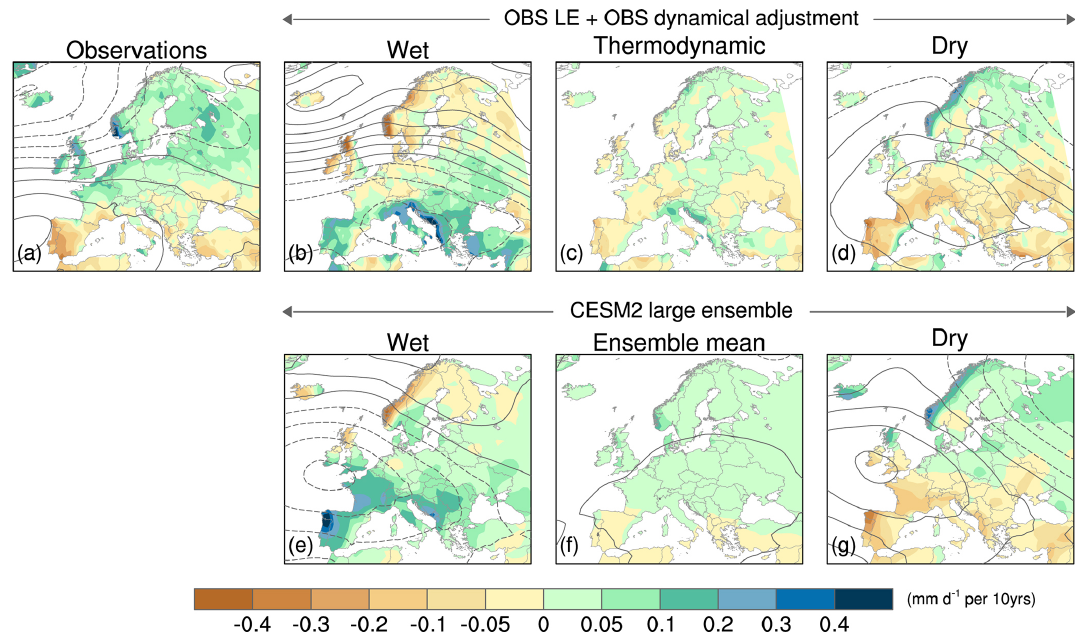
Figure 15. As in Fig. 14 but for precipitation (mmd − 1 per decade).